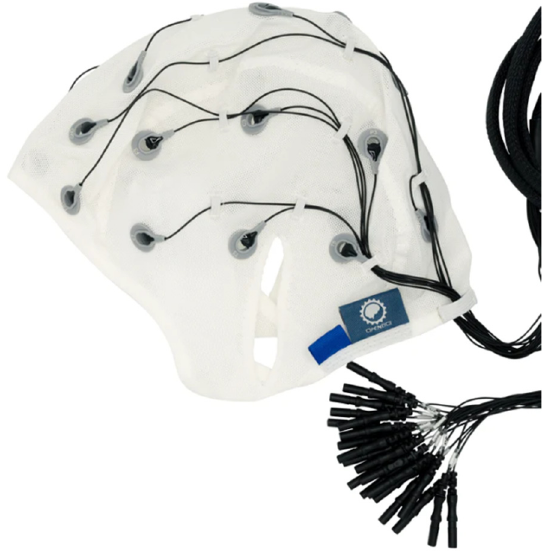
Figure 1. Photo of OpenBCI 21-channel electrode cap.